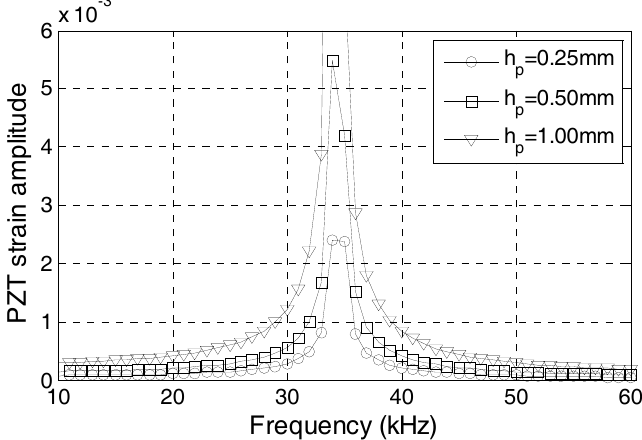
Figure 12. Frequency-strain amplitude curve with different waterproof layer thicknesses.